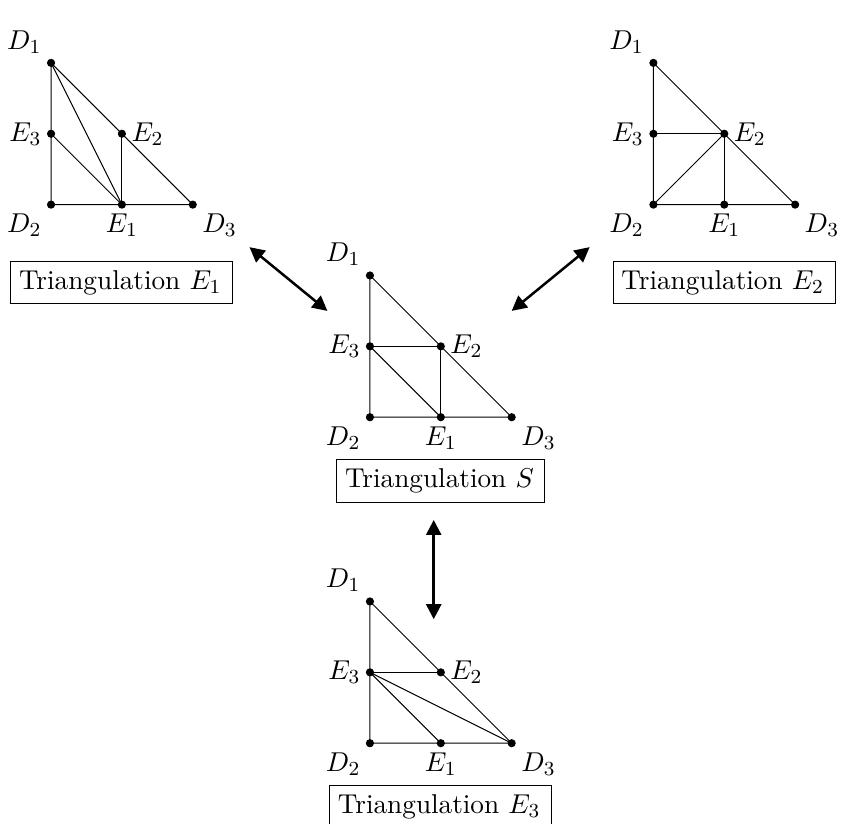
Figure 1 . The four different triangulation, the E 1 -, E 2 -, E 3 - and S -triangulation, of the projected toric diagram are given of the resolved C 3 / Z 2 × Z 2 . The left-right-arrows indicate the possible flop-transition between different triangulations, which shows that any flop-transition always involves the S